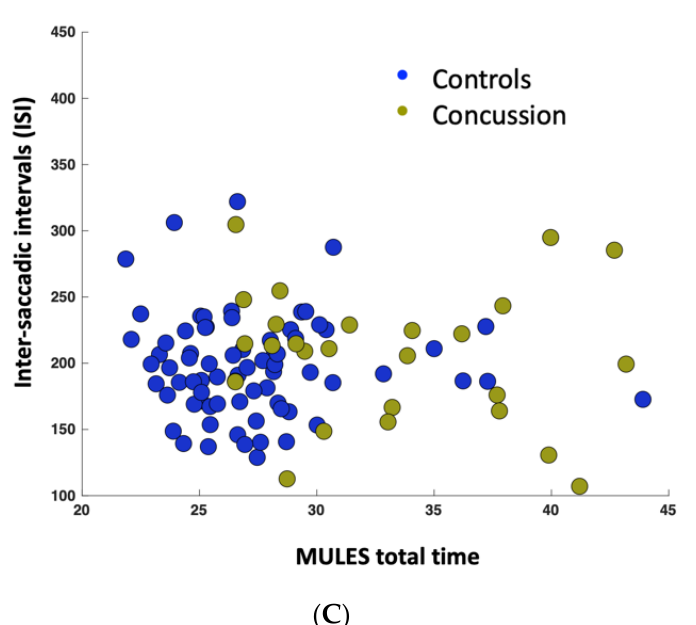
Figure 4. Total number of saccades correlated with ( A ) MULES total test time and ( B ) inter-saccadic intervals (ISI). No correlation was seen between MULES total test times and ISI ( C ). Control and concussion history participant performance could be discriminated 𝑑 ′ ≥ 1.0 (Figure 5) using both MULES times, 𝑑′ = 2.3 [95% CI 1.6, 3.3], and eye movement data, 𝑑′ = 2.8 [95% CI 2.1, 3.8].